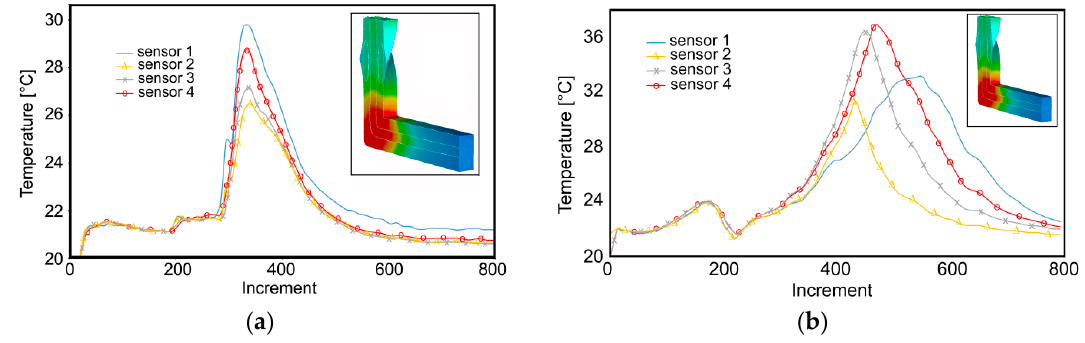
Figure 3. Development of temperature during: first pass ( a ); second pass ( b ).